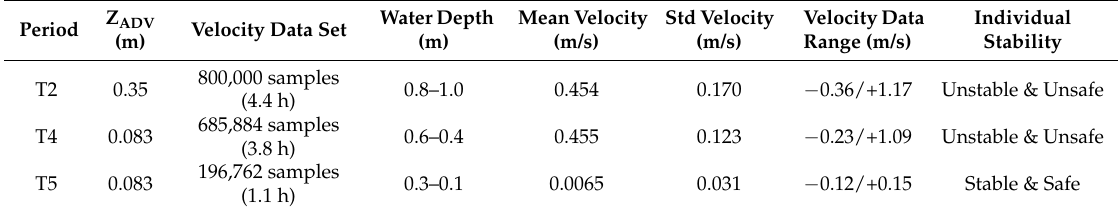
Table 1. Field measurements of instantaneous longitudinal velocity in Gardens Point Road, Brisbane on 12 and 13 January 2011.